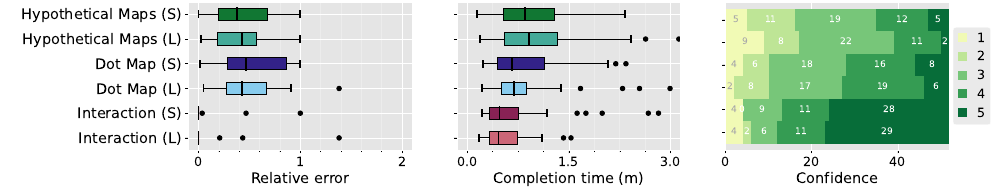
Figure 9. Results of the task measuring the impact of the size of the geographical regions. Variance. When considering both data sets together, data variance did not have a significant impact on any of the techniques, when considering relative error or completion time (Figure 10). However, like the size variable, variance significantly impacted the DDM technique when considering the taxi data. There were smaller errors when considering the large variance case; the median relative error for the large variance condition is below the lower quartile of the small variance